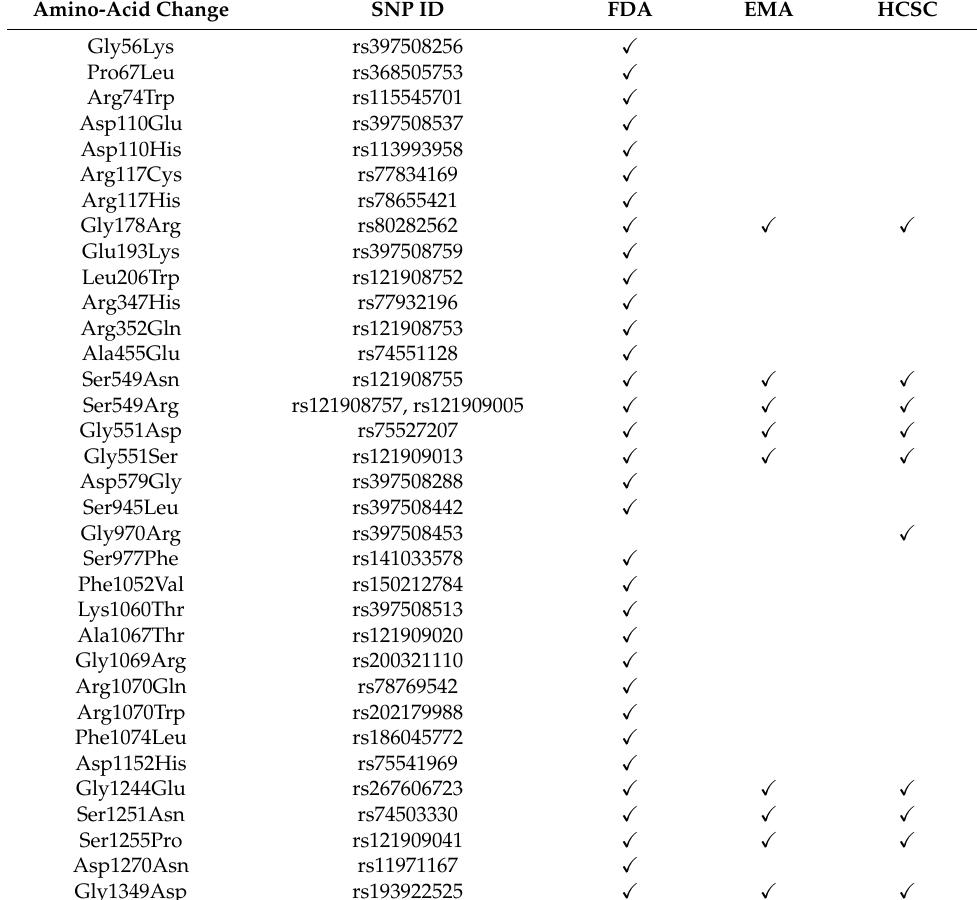
Table 2. CFTR DNA variants included in the drug label by different drug regulatory agencies. Amino-Acid